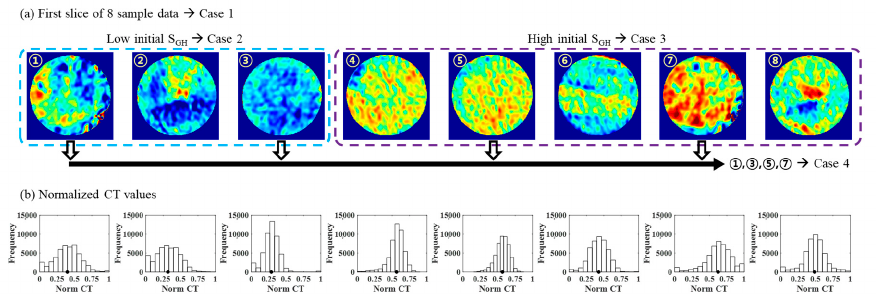
Figure 7. Normalized CT values of the eight GH samples in the “GH” stage for construction of the four cases. ( a ) Combination of the samples for each case; ( b ) normalized CT values of the first slice image in histogram.